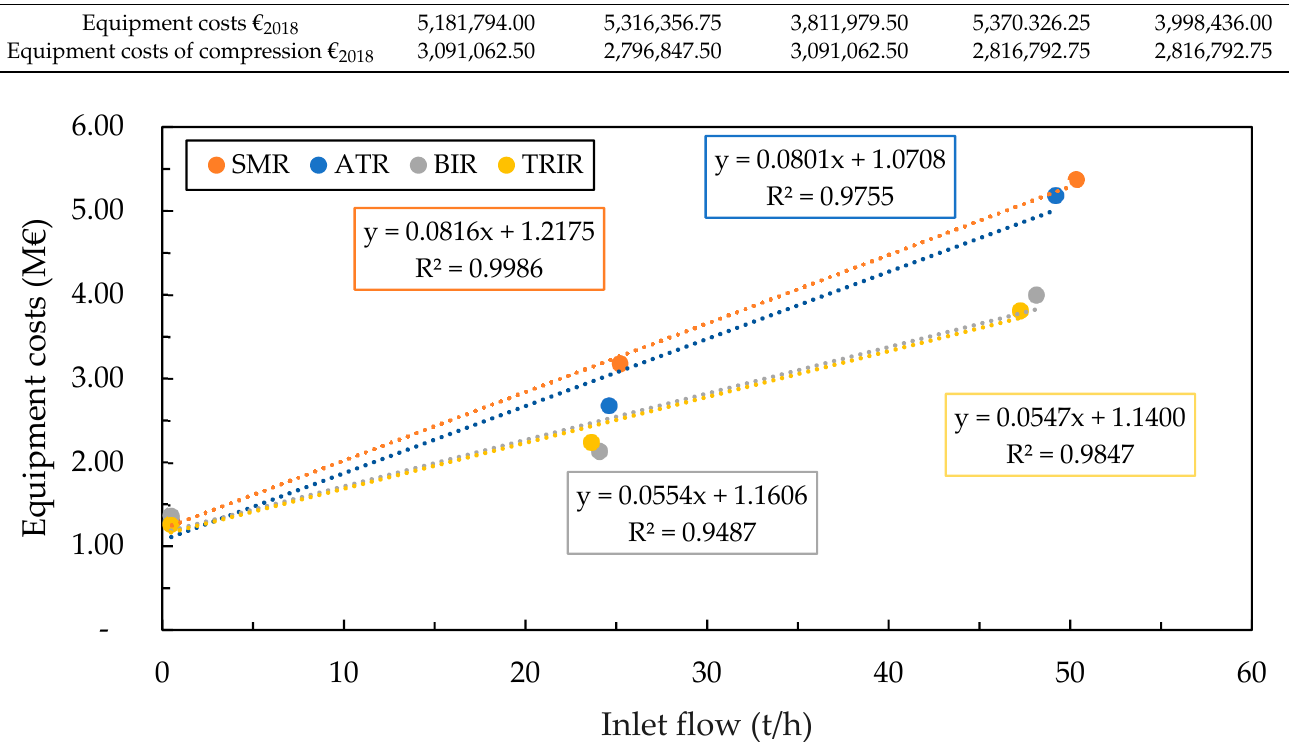
Figure 10. Economies of scale for Selexol process with different feed processes.